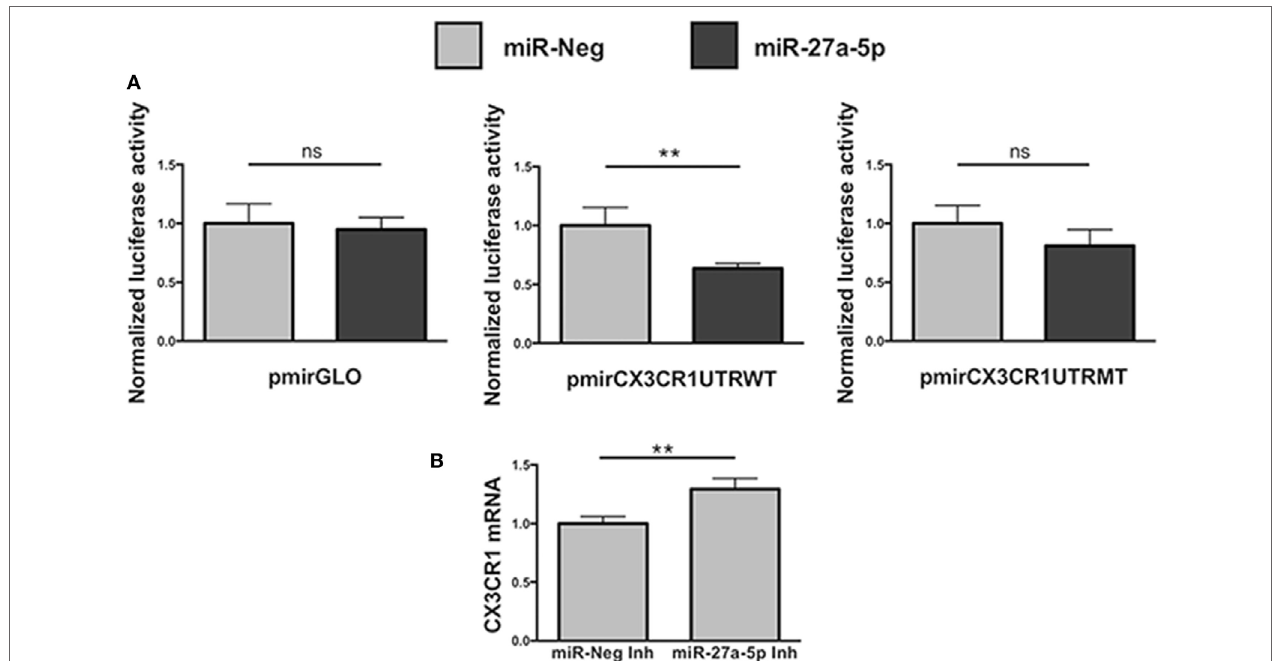
FigUre 4 | Functional interaction between miR-27a-5p and CX 3 CR1 mRNA. (a) Luciferase activity in HEK293T cells cotransfected with luciferase reporter construct containing the 3 ′ untranslated region (3 ′ UTR) CX 3 CR1 and miR-27a-5p mimics. Firefly luciferase activity was normalized to the renilla luciferase activity, expressed by the same vector. Data in quadruplicate are from one experiment of three performed. Luciferase activities are referred to the activity of cells transfected with the miRNA negative control whose expression has been arbitrarily assigned the value 1. pmirGLO, parental vector; pmirCX3CR1UTRWT, pmirGLO vector containing 700 bp of the CX 3 CR1 3 ′ UTR downstream of the firefly luciferase gene; pmirCX3CR1UTRMT, mutated version of pmirCX3CR1UTRWT containing the C > G mutation in the CX 3 CR1 3 ′ UTR target site; miR-Neg, miRNA mimic negative control. **p < 0.01; ns, not significant. (B) CX 3 CR1 mRNA expression in NK cells transfected with miR-27a-5p inhibitor (Inh) or with a negative control miRNA Inh. Cells were cultured for 72 h in the presence of 5 ng/mL of TGF- β 1. Data in triplicate are from one representative healthy donor of three analyzed (donors 8, 9, and 10). GAPDH has been used as reference control. Expression relative fold changes are referred to CX 3 CR1 mRNA expression in NK cells transfected with the negative control miRNA inhibitor, whom expression has been arbitrarily assigned the value 1. * p <